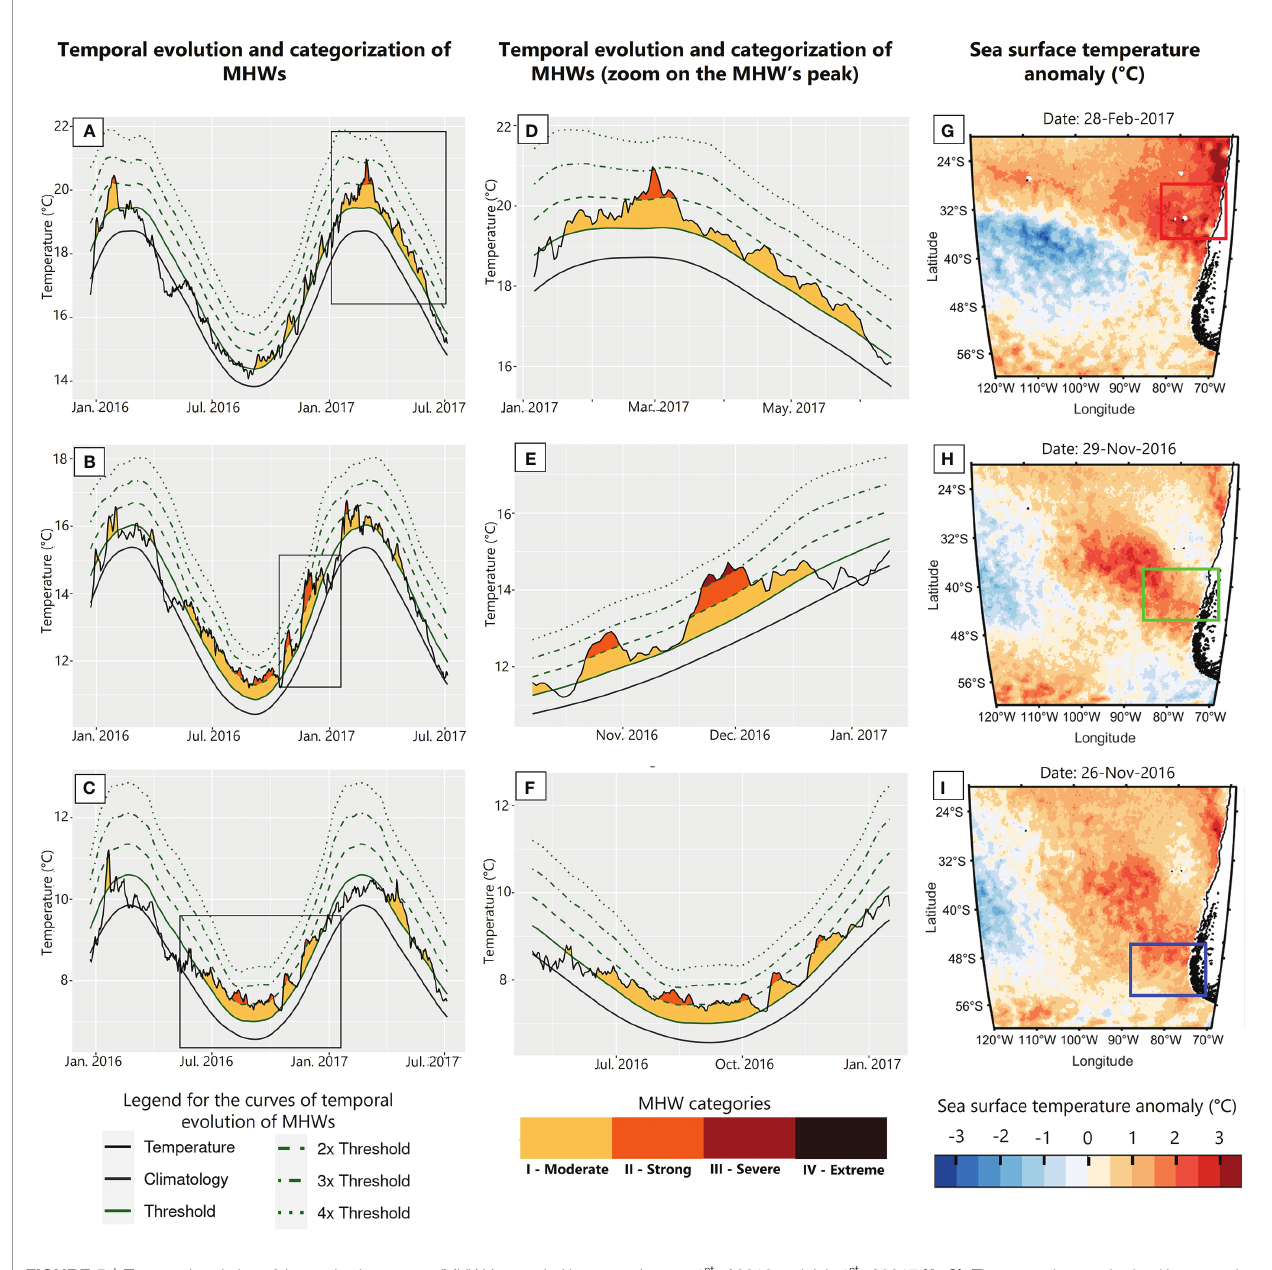
FIGURE 5 | Temporal evolutionof the marine heatwaves (MHWs) recordedbetween January1 st of 2016 and July 1 st of 2017 (A – C) . Those graphs are obtainedby averaging the sea surface temperature (SST) over the corresponding area. (D – F) Represents a zoom over the strongest event recorded for eacharea over this period, highlighted bythe blacksquare in the left column. For bothleft and central columns, the lower line of the graph(black andbold) represents the long-term climatology. The irregular black line represents the dailySST temperature. The greenbold line represents the threshold, the fi rst greendashed line is 2 times the threshold, the second greendashedline represents 3 times the threshold and the fi nal greendashedline represents 4 times the threshold. The MHWs categorization is representedby the colours with yellow, orange, redand dark purple corresponding respectively to Category I, II, III andIV. (G – I) Represents the SST anomaly on the dayof the main peak of the strongest event. The areas are represented bythe colouredsquares. Upper line corresponds to the Northernarea, middleone to the Transition area and bottom one to the Southern